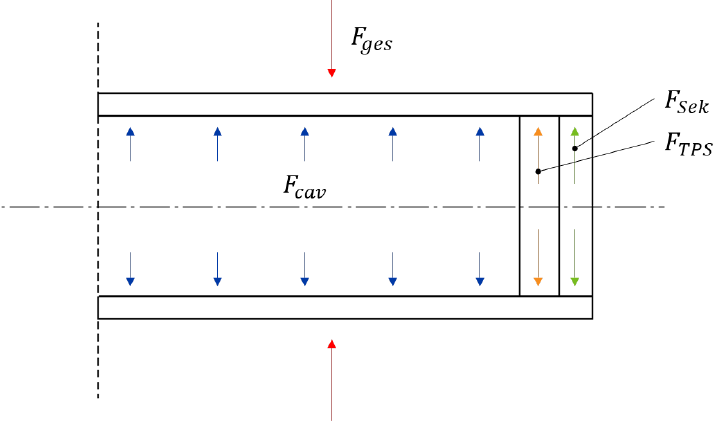
Fig. 10 Crossection of an IGU with illustrated forces.